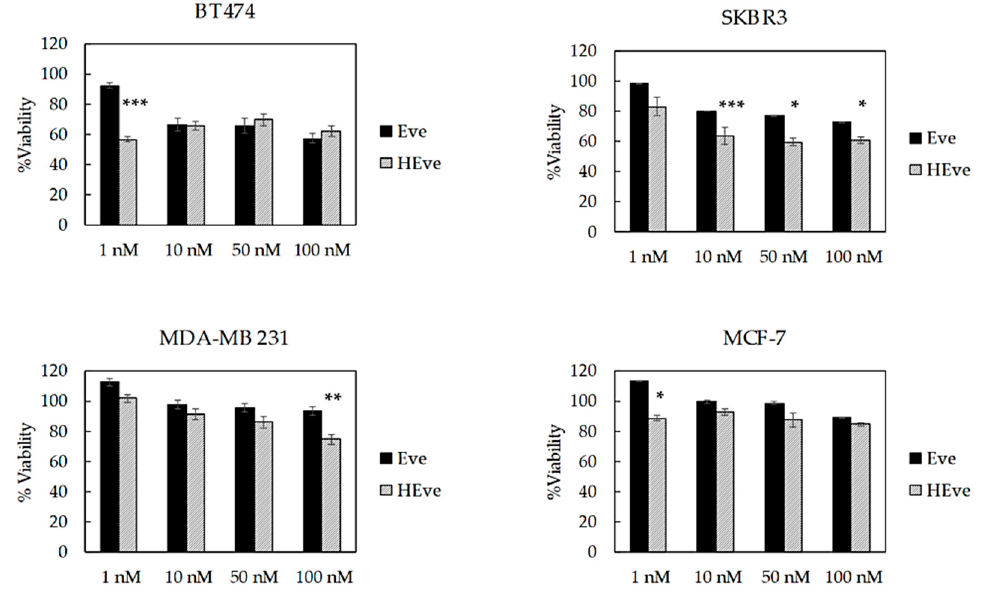
Figure 5. Viability of BC cells treated with Eve or HEve nanoparticles. BT474, SKBR3, MDA-MB 231, and MCF-7 cells were treated with 1, 10, 50, and 100 nM Eve or HEve for 72 h. Viability was assessed by measuring the conversion of MTS into formazan. Reported values are the mean of six replicates ± s.e., normalized to cell proliferation of untreated cells. Statistical significance of HEve vs. free drug, * p < 0.05; ** p < 0.005; *** p < 0.0005 (Student’s t -test).